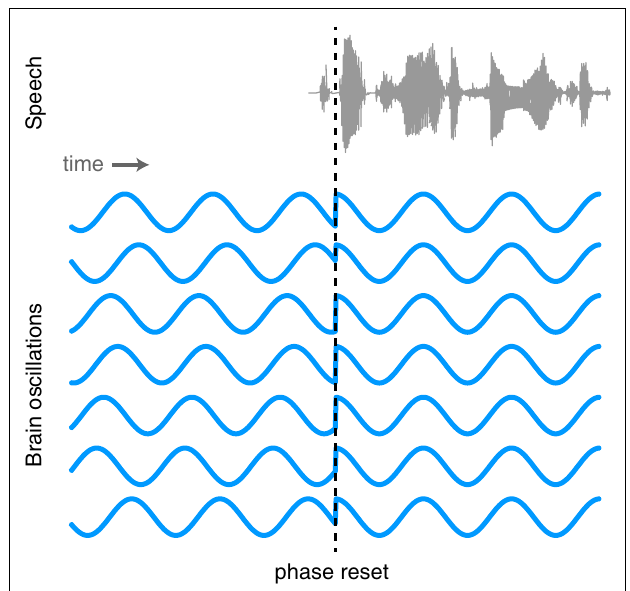
FIGURE 5 | Illustration of the phase of ongoing neural oscillations being reset by an external stimulus. Prior to the stimulus event the phases of the oscillations are random, but following the stimulus they are